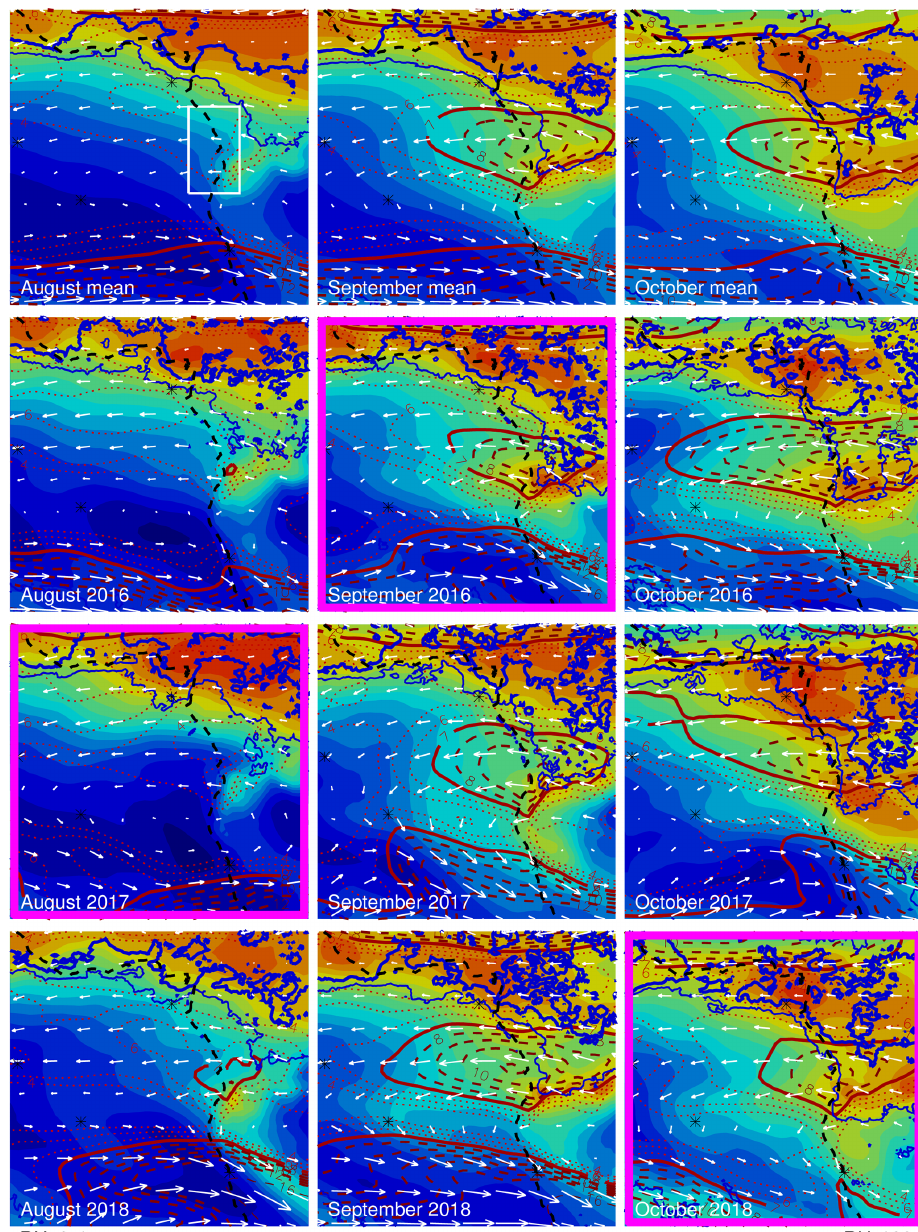
Figure 8. The same as Fig. 6 except for the 19-year mean (2000–2018) and 3 years of the ORACLES deployment (2016, 2017, and 2018). The boxes with magenta frames indicate the ORACLES deployment months. The white rectangle represents the area over 8–16 ◦ E and 14–3 ◦